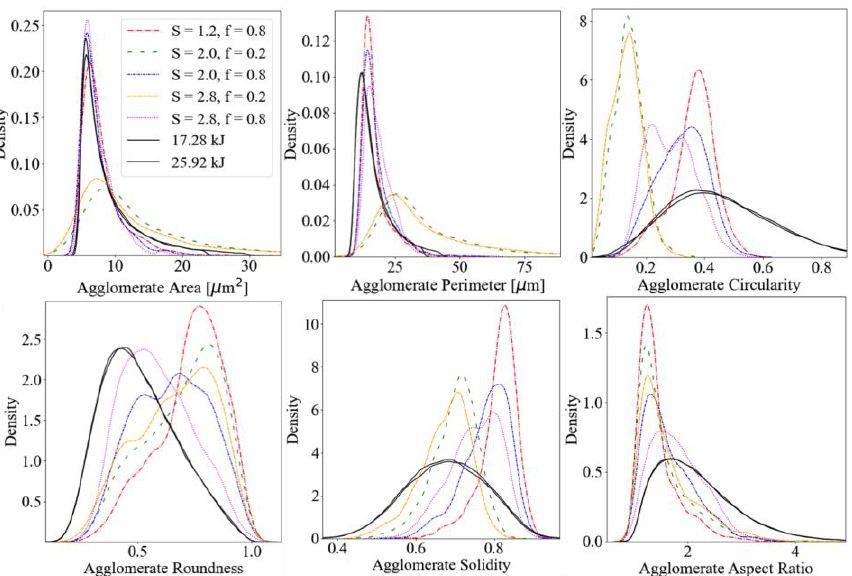
Figure 7. Kernel density estimate plots of various shape descriptor statistics from ImageJ particle analysis of collections of microscopy images of well dispersed samples imaged at 100 × magnification (solid lines) and collections of simulated film RVEs (dashed/dotted lines) with varying stochastic model agglomerate placement parameters.